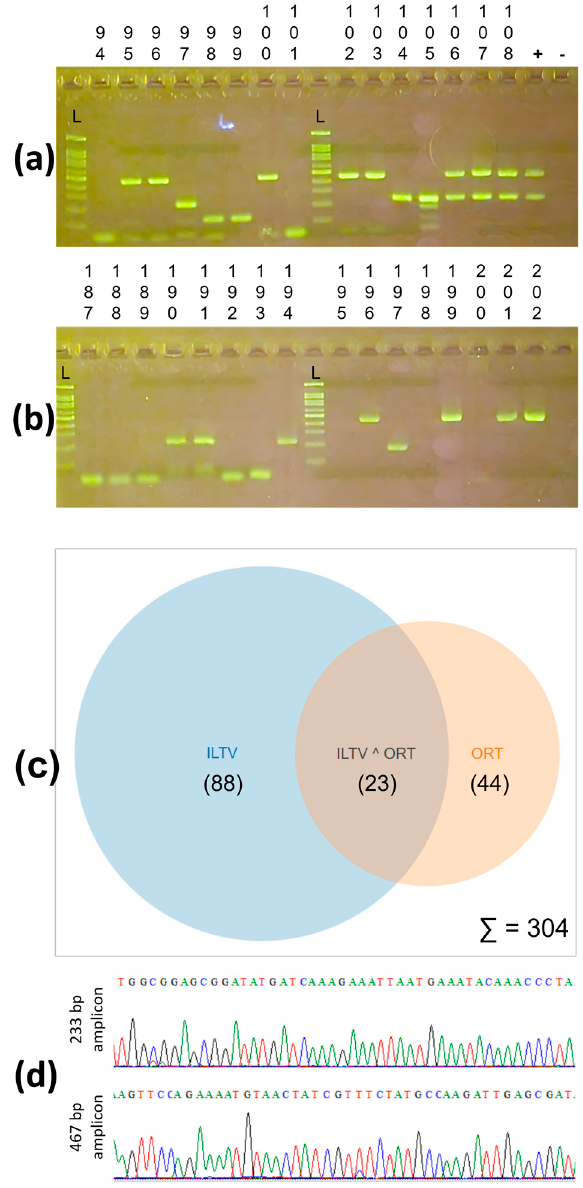
Figure 5. The diagnostic results of the multiplex PCR. ( a , b ) Agarose electrophoresis of fi eld samples. One hundred bp DNA ladder (L); the lowest band was one hundred bp, and the brightest band was fi ve hundred bp. ( c ) Venn diagram of the number of positive samples for ILTV, ORT, and both pathogens. ( d ) Partial results of sequencing chromatograms of the 233 and 467 bp amplicons.